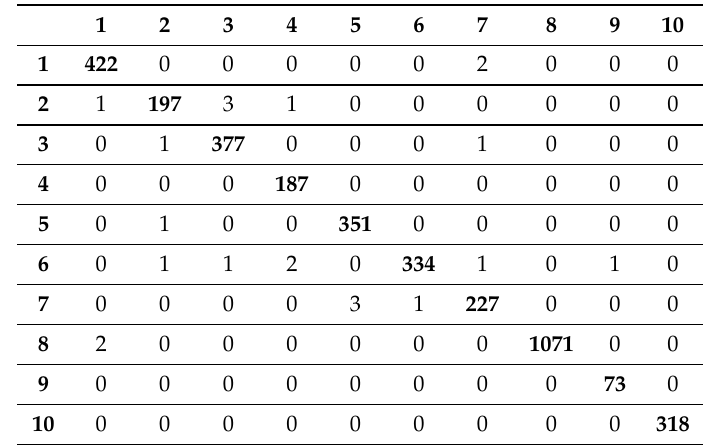
Table 7. Confusion matrix based on GoogleNet model. ( 1 ) Bacterial pot; ( 2 ) Early Blight; ( 3 ) Late Blight; ( 4 ) Leaf Mold; ( 5 ) Septoria Leaf Spot; ( 6 ) Spider Mites; ( 7 ) Target Spot; ( 8 ) Yellow Leaf Curl Virus;